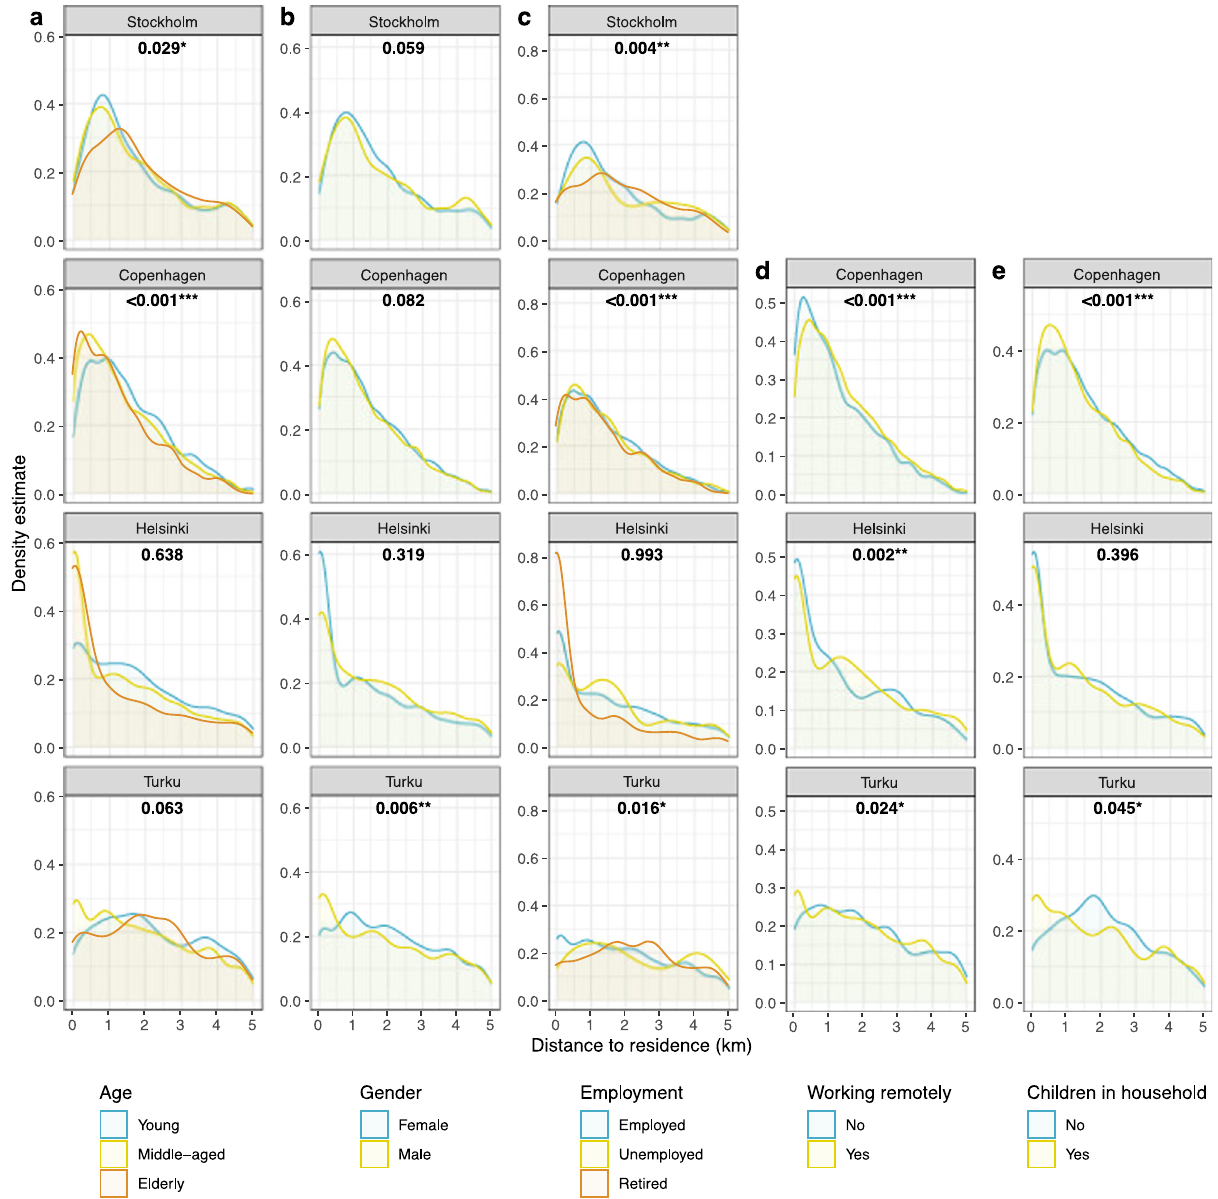
Fig. 2 Distance between respondents ’ place of residence and outdoor recreation sites. Walking distance in km through the street network is given on x -axis and kernel density estimates are given on y -axis. Panels show data broken down by city and a age, b gender, c employment, d remote working, and e children in household. The numbers in each plot correspond to the p -value for the Mann – Whitney U -test or Kruskal – Wallis test for differences between groups shown in the plot. See also Supplementary Tables 3, 5, 7 and 9 on statistical results as